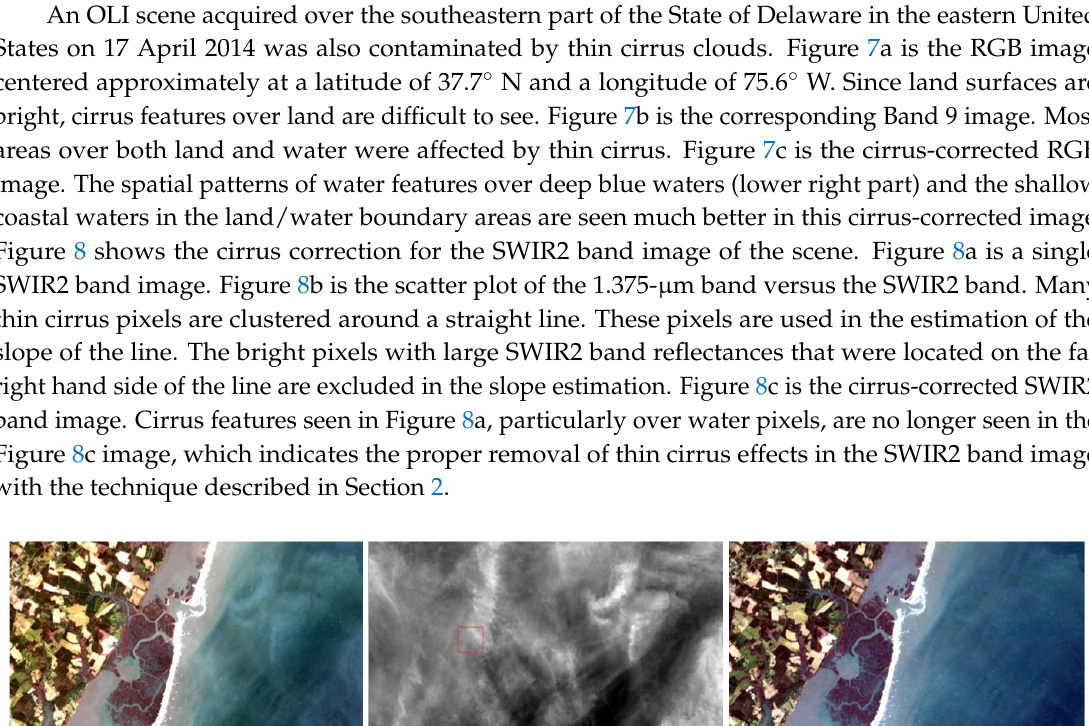
Figure 6. ( a ) A Landsat 8 OLI SWIR2 image acquired over Cape Breton Island in eastern Canada (northeast to Halifax) on 16 September 2014; ( b ) The scatter plot of Band 9 (cirrus) versus SWIR2 band; ( c ) The cirrus-corrected SWIR2 image.